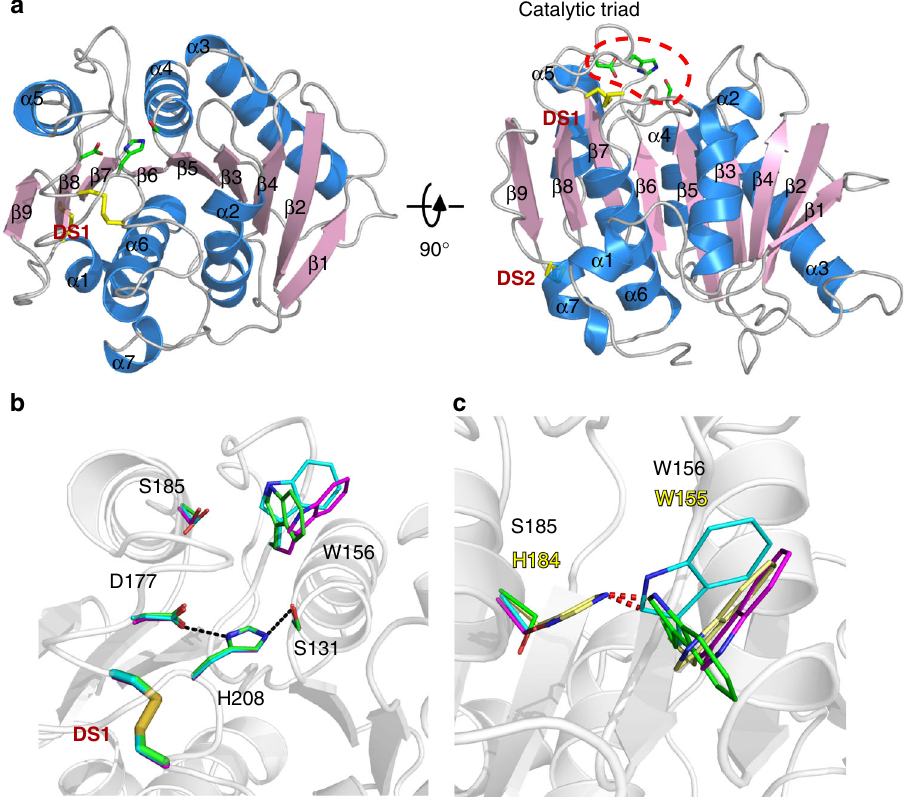
Fig. 2 Overall structure of apo-form PETase. a The PETase structure is presented as a cartoon model. The catalytic triad (red dash line circle, top left) and disul fi de bridges (red labels) are shown as sticks. b Three polypeptide chains in an asymmetric unit are superimposed. W156, S185 and the catalytic triad of A (green), B (cyan), and C (magenta) chain are shown in the foreground. Dash lines indicate distances < 3.5 Å. c The PETase in this study is compared with the Thermobi fi da fusca PET degrading hydrolase (PDB ID, 4CG2). The corresponding residues of W156 and S185 in the latter enzyme are colored yellow. Red dash lines indicate distances < 1.5